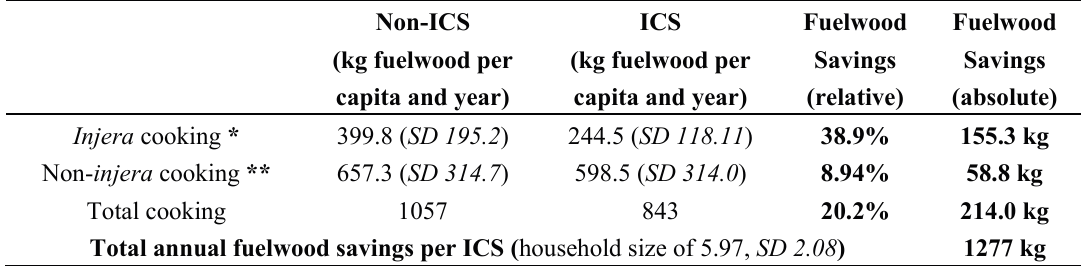
Table 5. Fuelwood savings due to the introduction of “ Mirt ” stoves on a yearly basis. Non-ICS (kg fuelwood